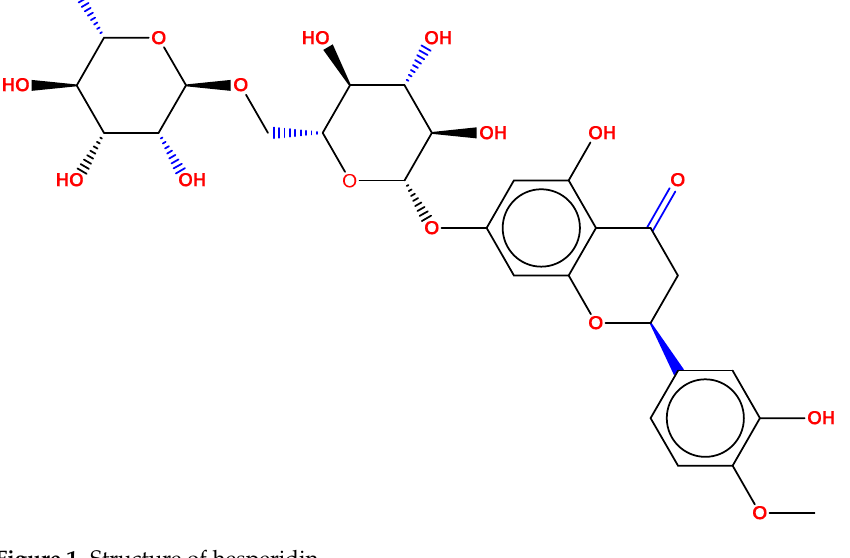
Figure 1. Structure of hesperidin.